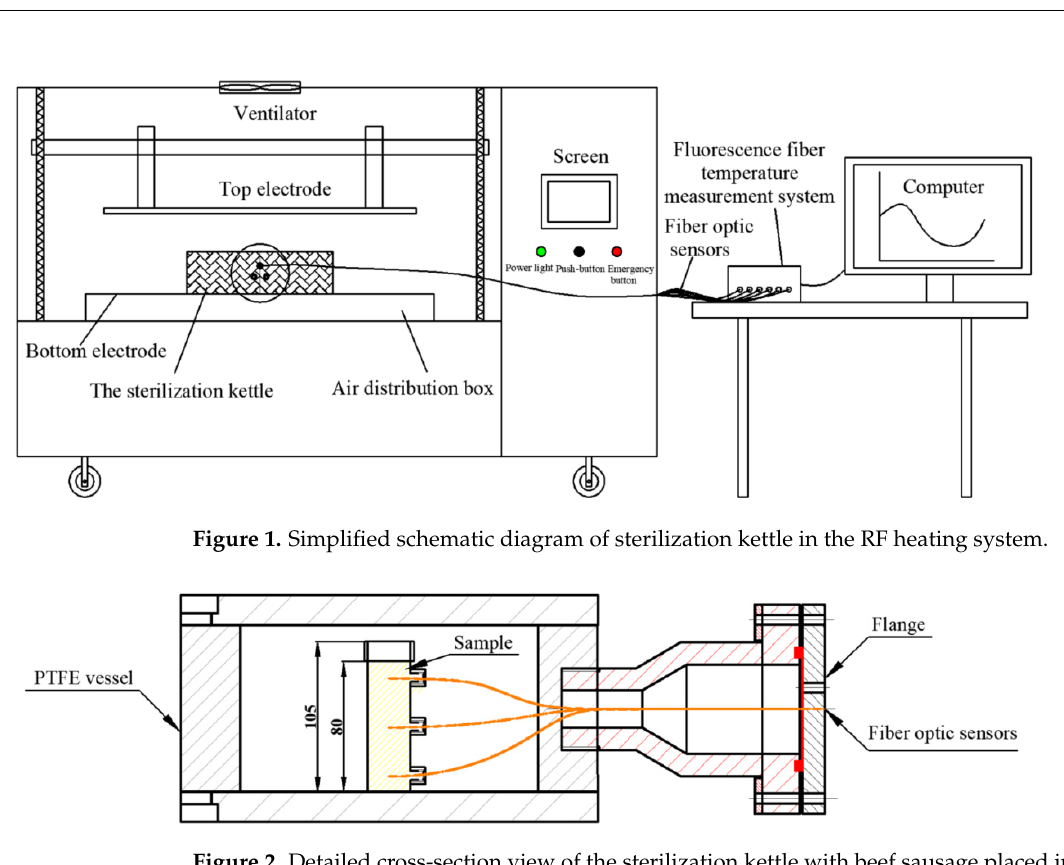
Figure 2. Detailed cross-section view of the sterilization kettle with beef sausage placed in the center and fiber optic sensor inserted in the sample.